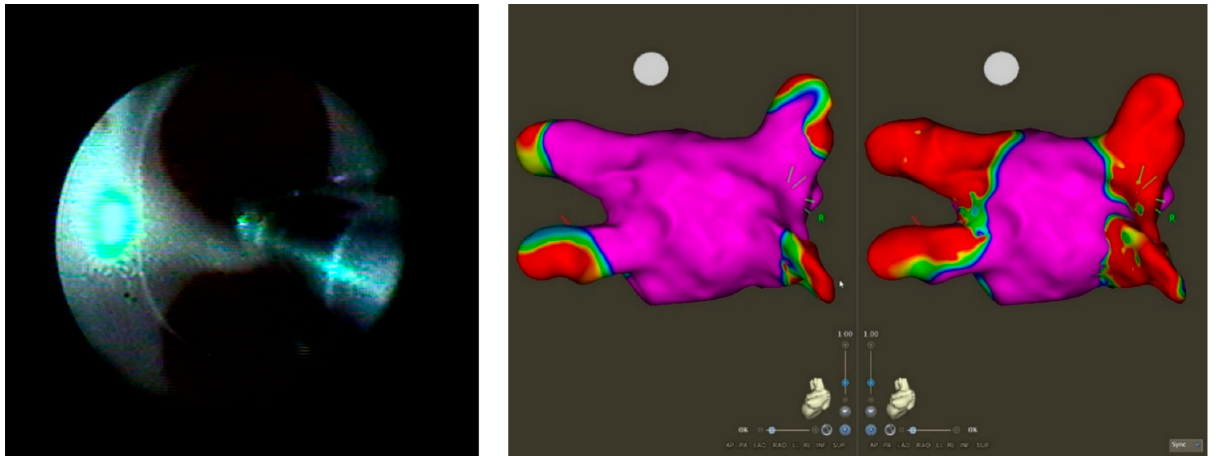
Figure 2. Ablation of the left pulmonary vein with visually guided laser balloon (VGLB) ( left ) and pre- and postablation electroanatomical voltage map, 0.2–0.5 mV, posterior–anterior view ( right ) with